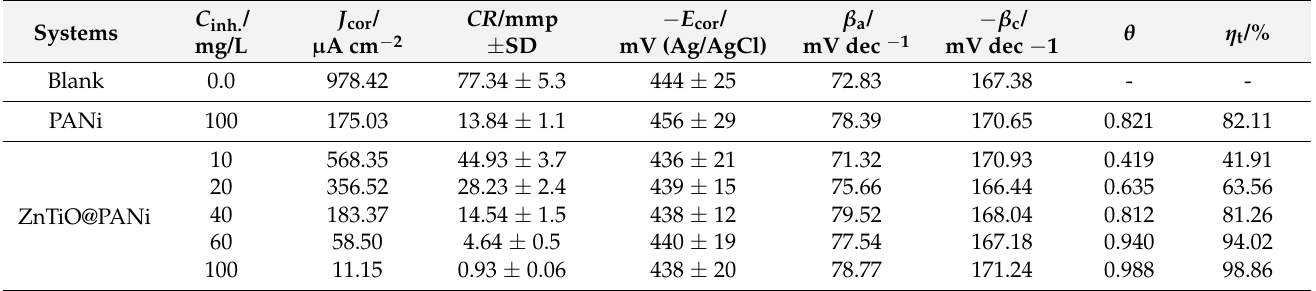
Table 2. Potentiodynamic restrictions of CS-alloy corrosion in the blank molar HCl containing 3.5% NaCl and with the addition of diverse doses ZnTiO@PANi at 298 K.